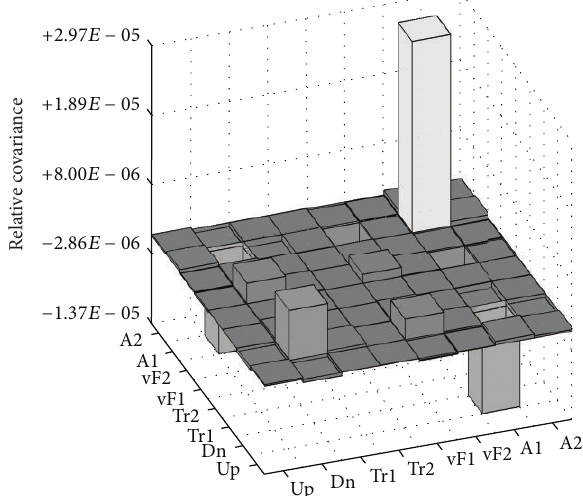
Figure 25: Homogenized property covariance due to 𝜎 U 238 𝛾 covari- ance using